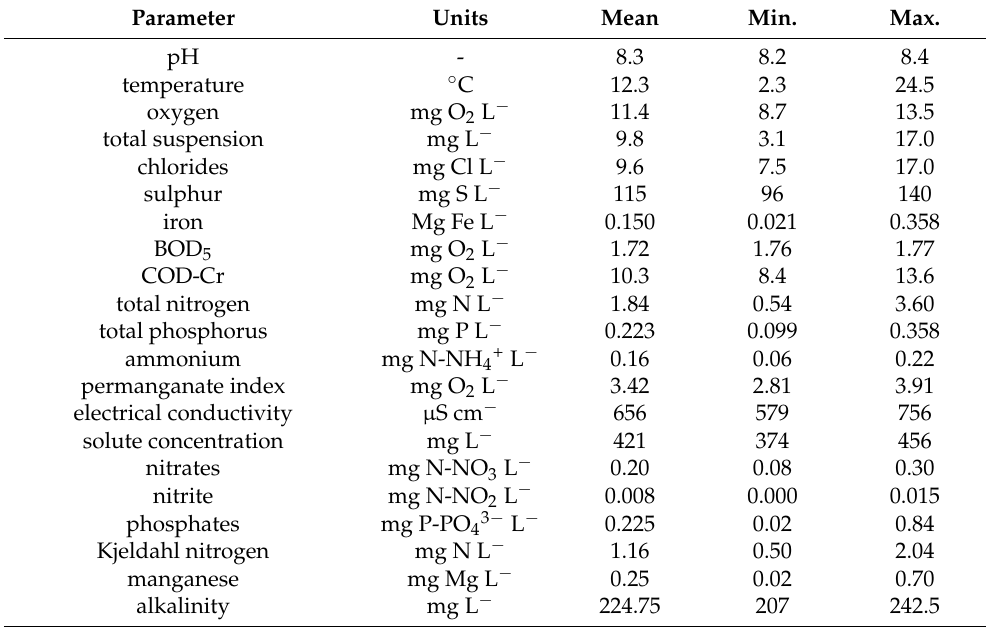
Table 2. Water quality in the Kleczew Reservoir (based on data of Konin Brown Coal Mine—PAK KWB